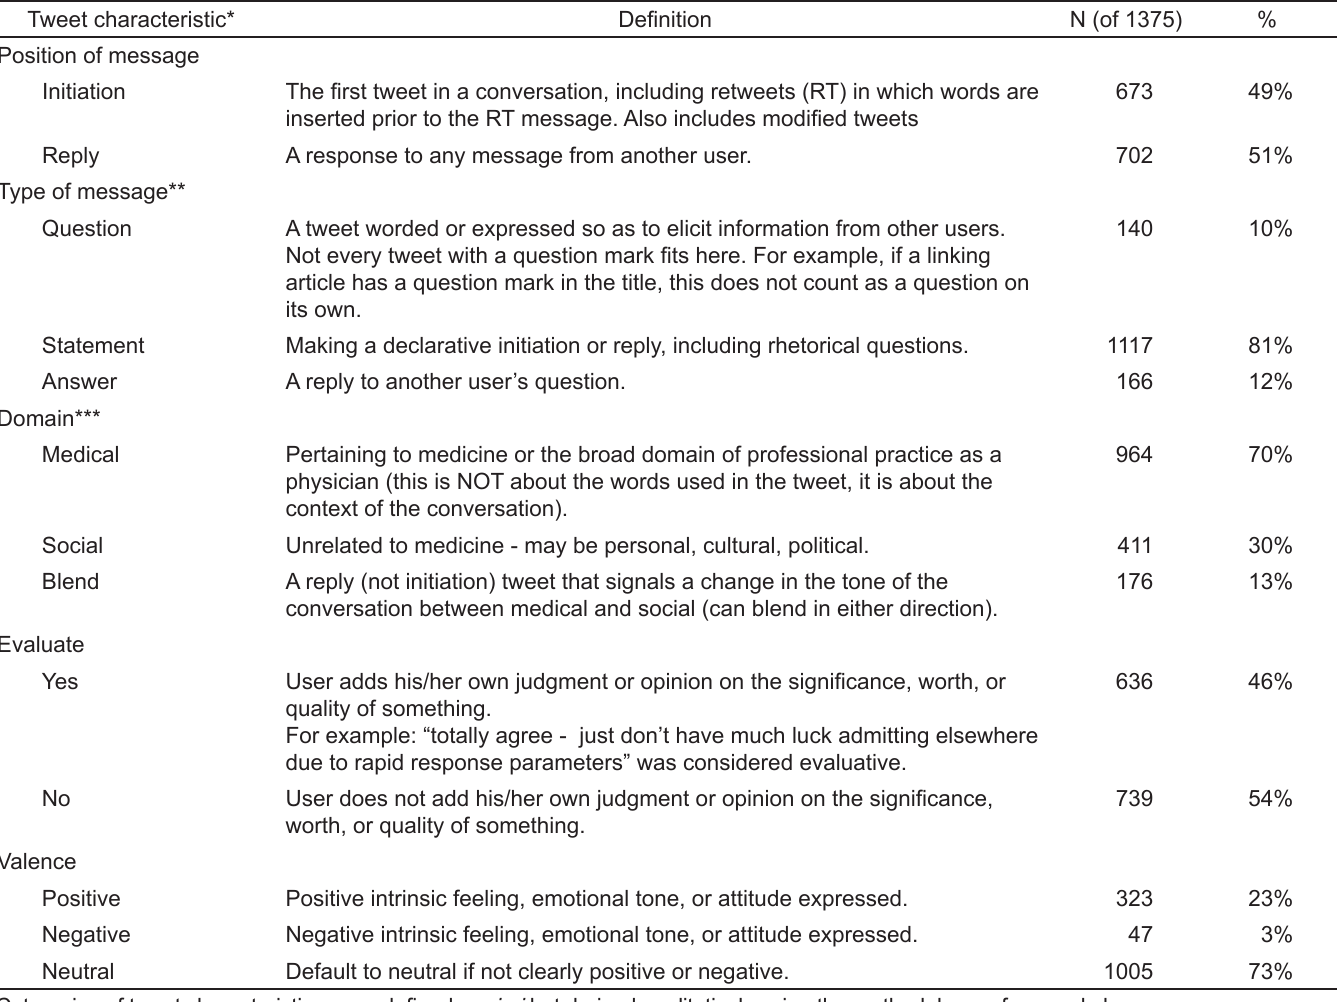
Table 2. Descriptive categories of tweet characteristics of influential emergency